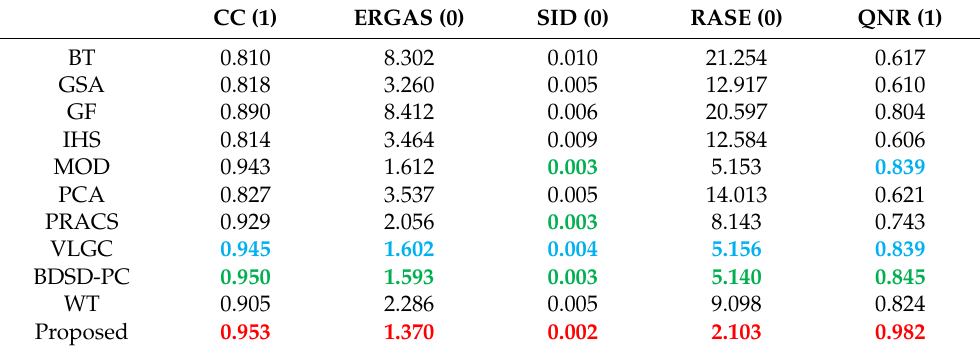
Figure 8. The fusion results of ten different methods on the third image pair: ( a ) BT; ( b ) GSA; ( c ) GF; ( d ) IHS; ( e ) MOD; ( f ) PCA; ( g ) PRACS; ( h ) VLGC; ( i ) BDSD-PC; ( j ) WT; ( k ) the proposed method; ( l ) the reference MS image. Table 5. Objective evaluation of the experimental results on the fourth image Table 4. Objective evaluation of the experimental results on the third image pair.